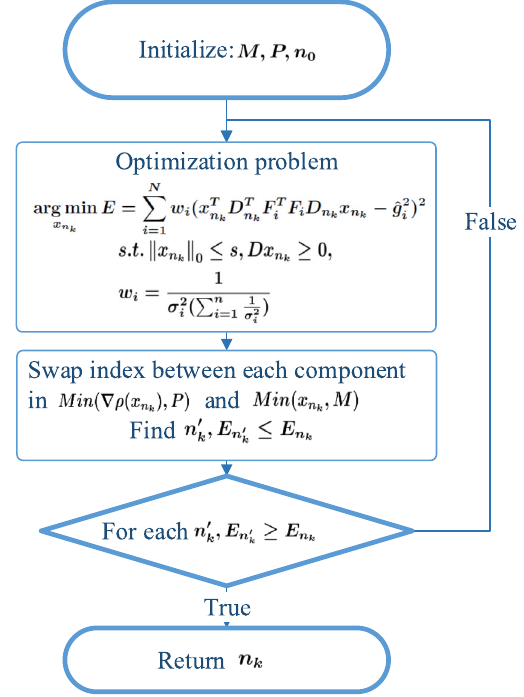
FIG. 1. Flow chart of the WGESPAR algorithm. Min ð A; B Þ denotes the index array of the B components of A with the lowest value. The index array of the nonzero elements is initialized as n 0 , and the parameters of M and P are fixed during the reconstruction